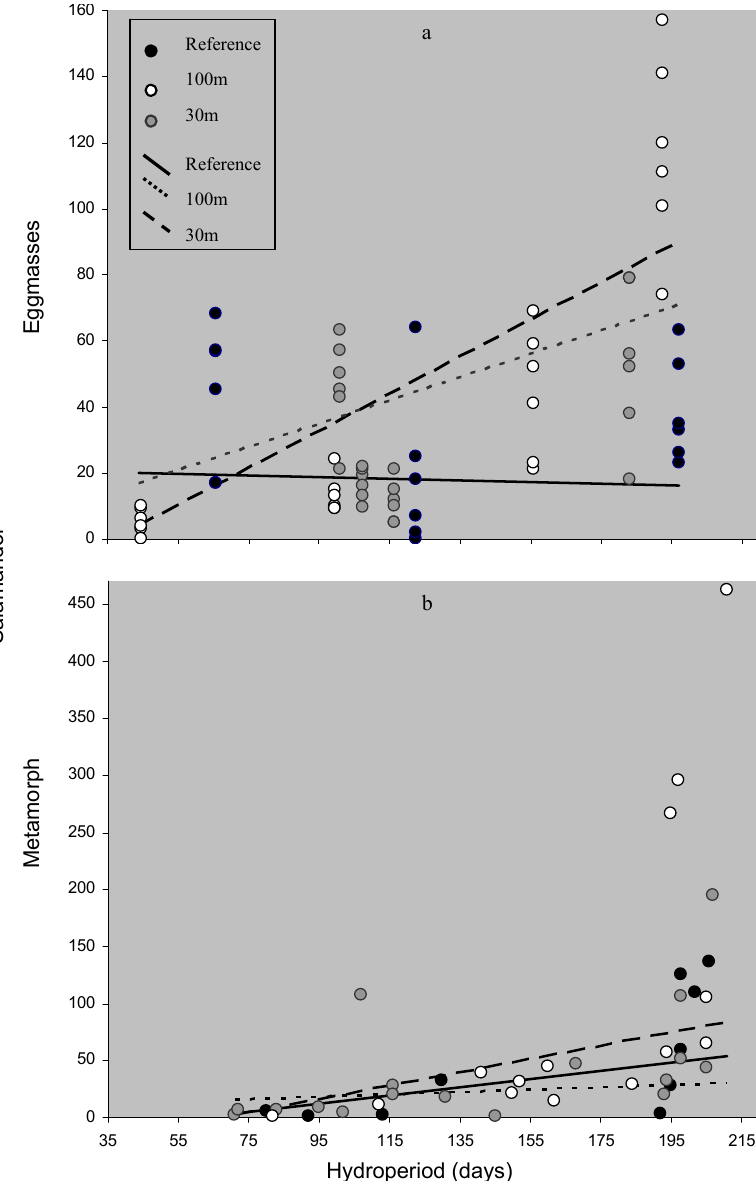
Figure 3. Spotted salamander abundance by hydroperiod (days) across 3 experimental forestry treatments at 11 natural ephemeral pools in east-central Maine, USA. Treatments were: reference (uncut), 100 m undisturbed buffer, and 30 m undisturbed buffer. ( a ) Eggmass abundance by mean-pool hydroperiod; ( b ) metamorph abundance, in pools that produced metamorphs, by current-year hydroperiod. Lines represent predicted values based on the fixed-effects regression coefficients.